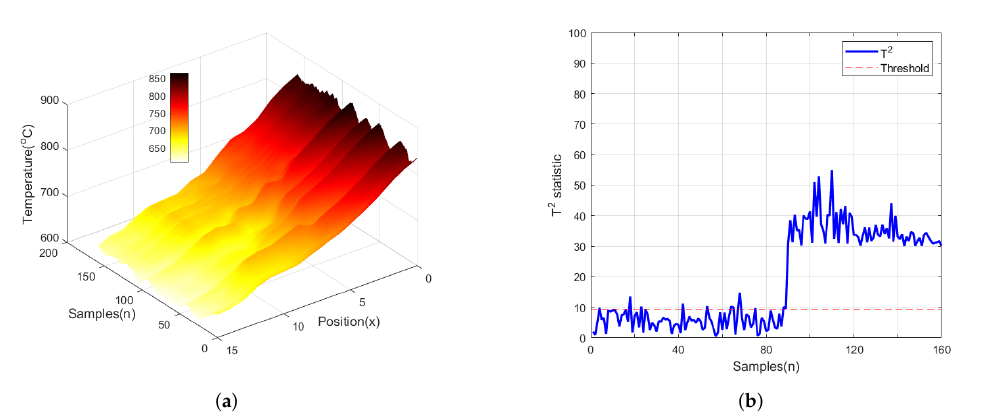
Figure 14. The temperature distribution ( a ) and monitoring result ( b ) of fault